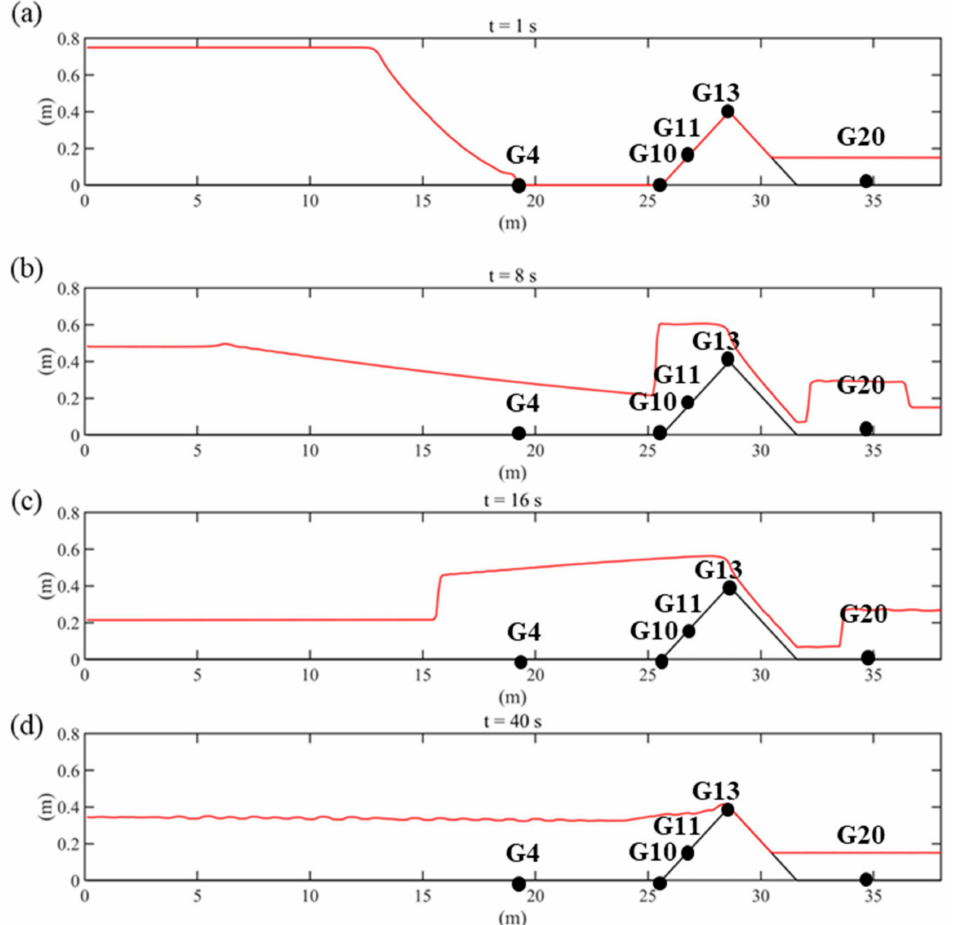
Figure 9. Free surface elevation during the flood evolution in the experiment. ( a ) At 1 s, flood flows at the dry bed; ( b ) at 8 s, the flood flows up to the obstacle and has an influence downstream; ( c ) at 16 s, all the upstream water flows to the obstacle and a run-up forms; ( d ) at 40 s, the flow downstream remains static, with waves at the upstream